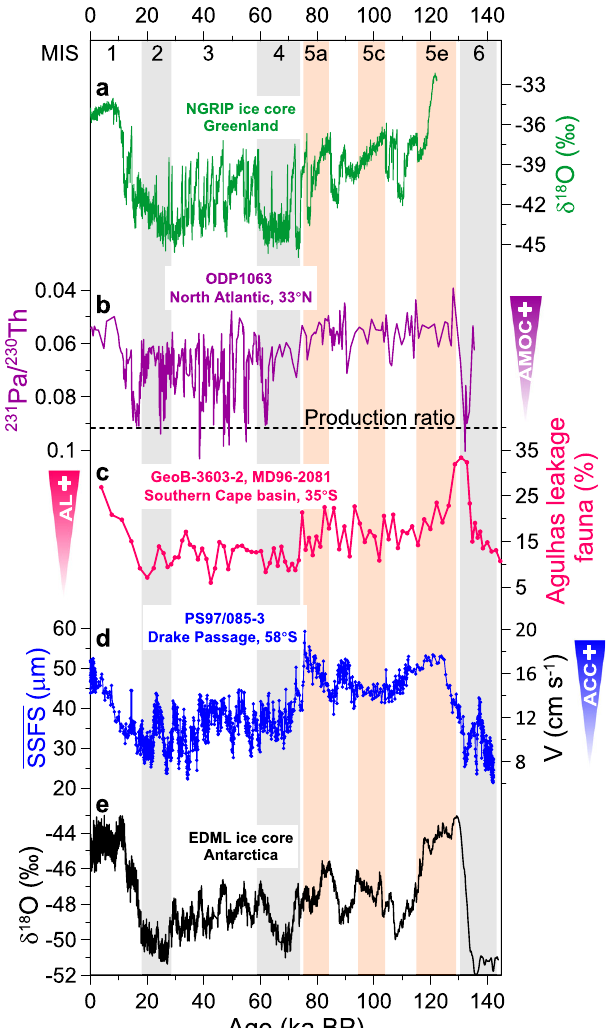
Fig. 5 Reconstructed changes in ACC strength compared with paleoclimatic records over the past 140 ka. a NGRIP oxygen isotope record 70 . b Bermuda Rise 231 Pa/ 230 Th data 44,59,60 , indicating the AMOC strength. Dashed line is production ratio ( 231 Pa/ 230 Th = 0.093), suggesting no transport. c Planktic foraminiferal fauna re fl ect the intensity of the Agulhas leakage 58 . d SSFS as a fl ow-speed proxy for the current strength (blue, this study) and the transferred ACC fl ow speeds. e Oxygen isotope record from the EDML ice core 45 . Vertical gray bars mark glacial periods and pink bars mark the warm stages during MIS